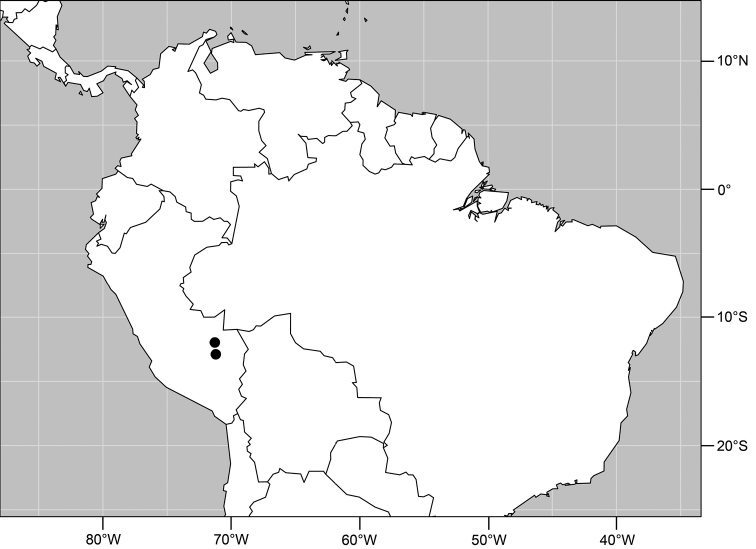
Distribution of Polytrichophora flavella sp. n.